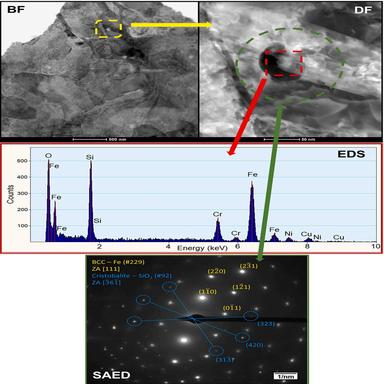
TEM bright-field (BF) and dark-field (DF) images of a H900-4 h sample, indicating the presence of a crystalline silicon oxide particle, as revealed by EDS and selected area electron diffraction (SAED) measurements.